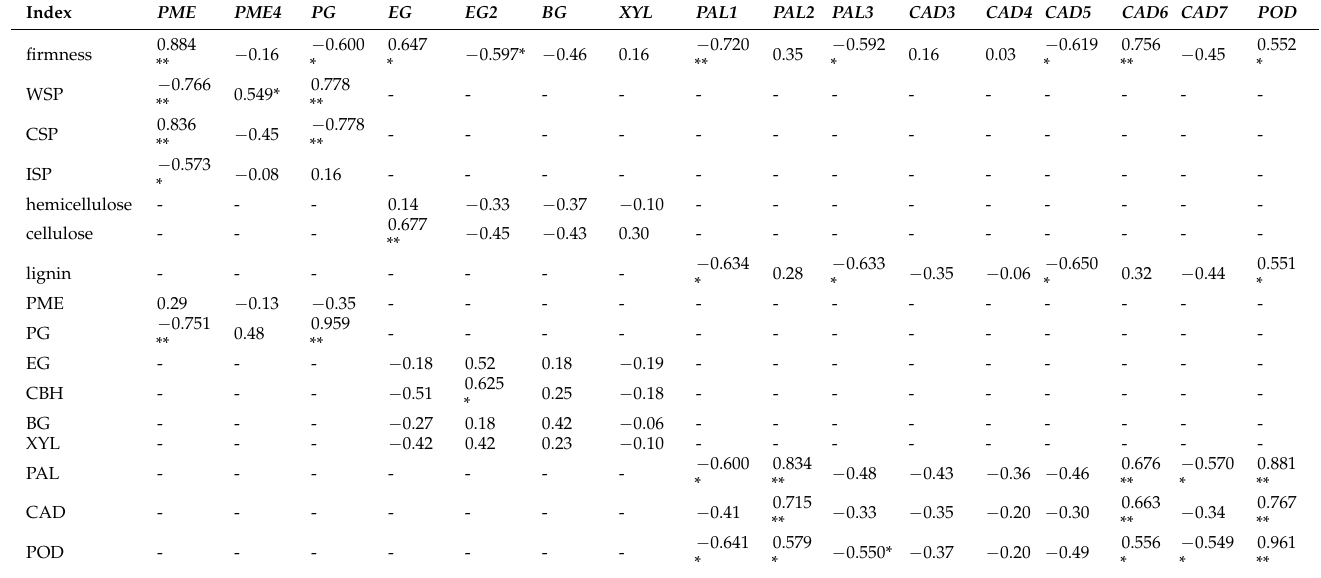
Table 3. Correlation analysis of cell wall components and hydrolase activities with gene